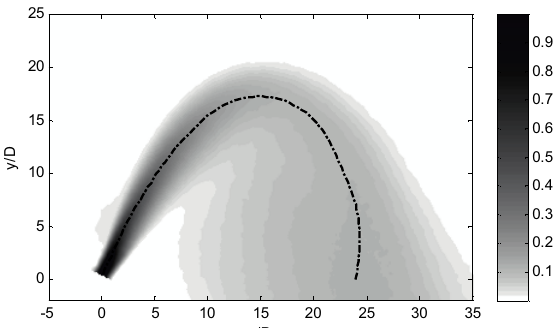
Figure 1. Map of the non-dimensional mean velocity U/U (U is the maximum velocity at the outlet) for max max an INBJ with Re = 1000, Fr = 8, θ = 65°; the dash- dotted black line is the jet axis (defined as the locus of maximum intensity velocity) by U , in the near field of two INBJs with Re = 1000, max θ = 65° and two different Fr: Fr = 8 and 15 (Figure 2a and 2b respectively). In the plots, the jet axis is displayed as a dash-dotted black line. The two